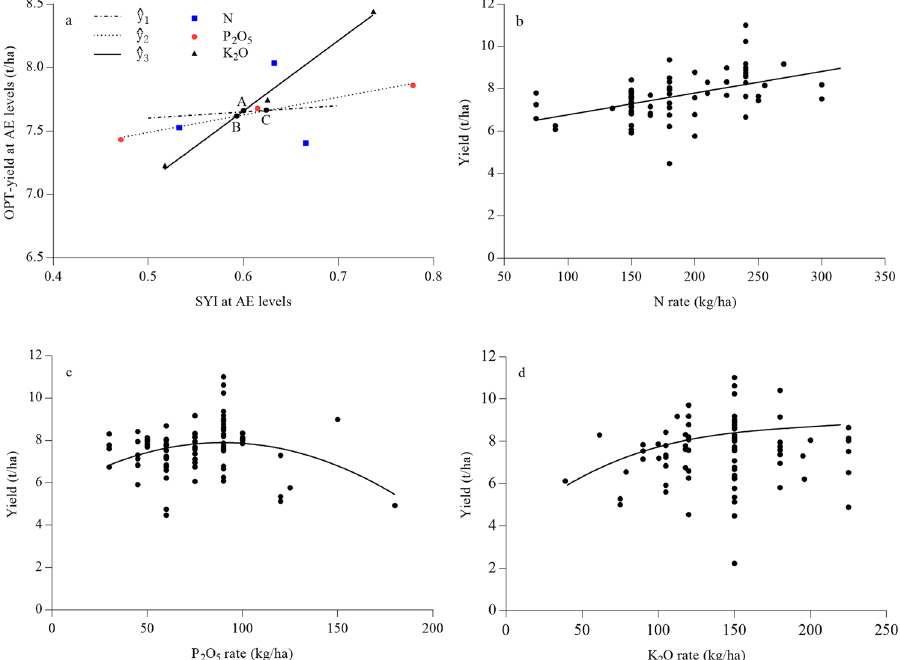
Figure 6. Optimum yield ( ŷ ) at agronomic efficiency (AE) and experimental yield ( y 1 , y 2 , y 3 ) modelled as functions of the sustainable yield indices (SYI) ( Ŝ ), N ( x 1 ), P 2 O 5 ( x 2 ) and K 2 O ( x 3